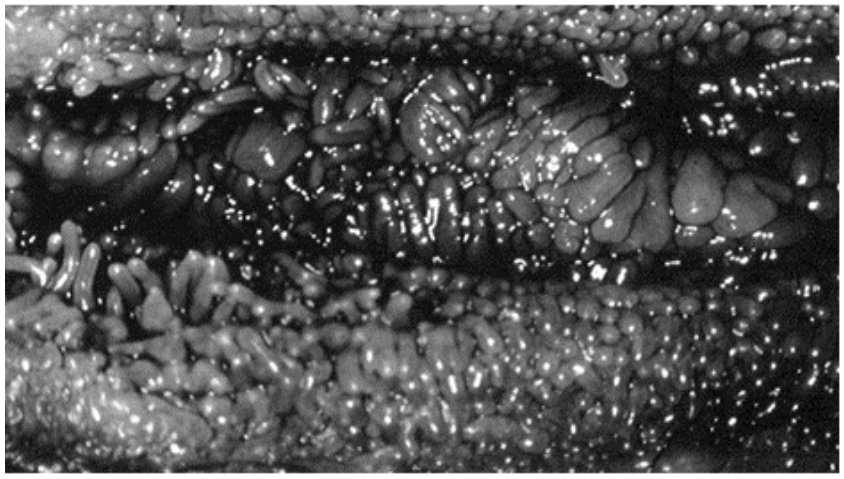
FIGURE 1 . Typical appearance of vulvar vestibular